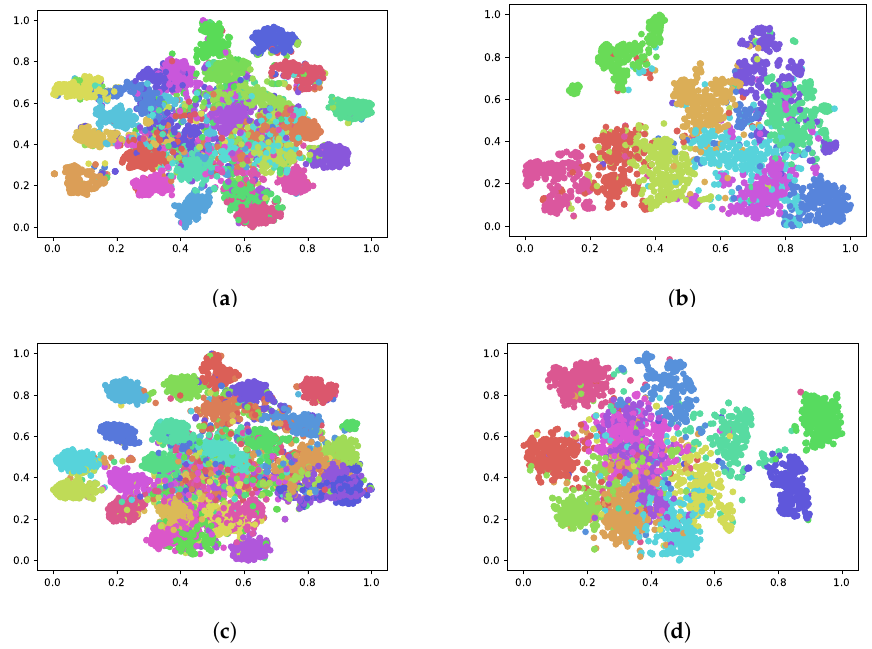
Figure 1. The t-distributed stochastic neighbor embedding (t-SNE) visualization; ( a , b ) indicate the training features and the test features of the NWPU-RESISC45 dataset, respectively; ( c , d ) represent the training features and test features of the RSD46-WHU dataset,